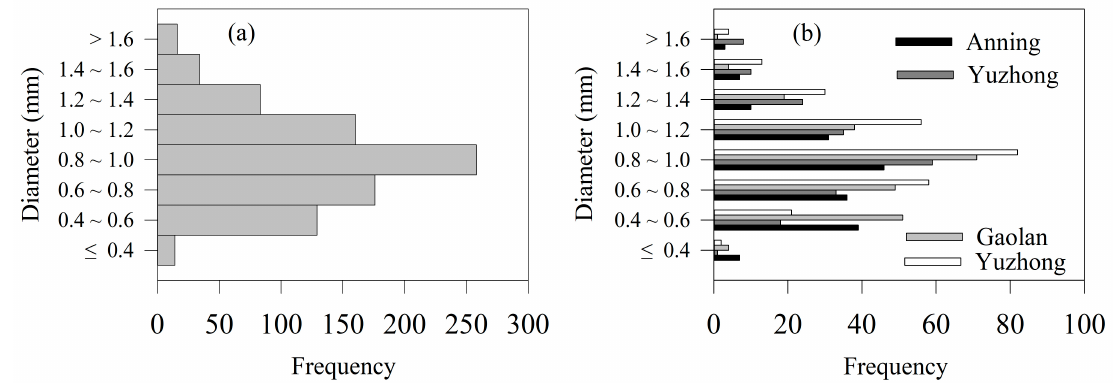
Figure 2. Frequency of precipitation events for different rain drop diameters: ( a ) Lanzhou and ( b ) four sampling sites.